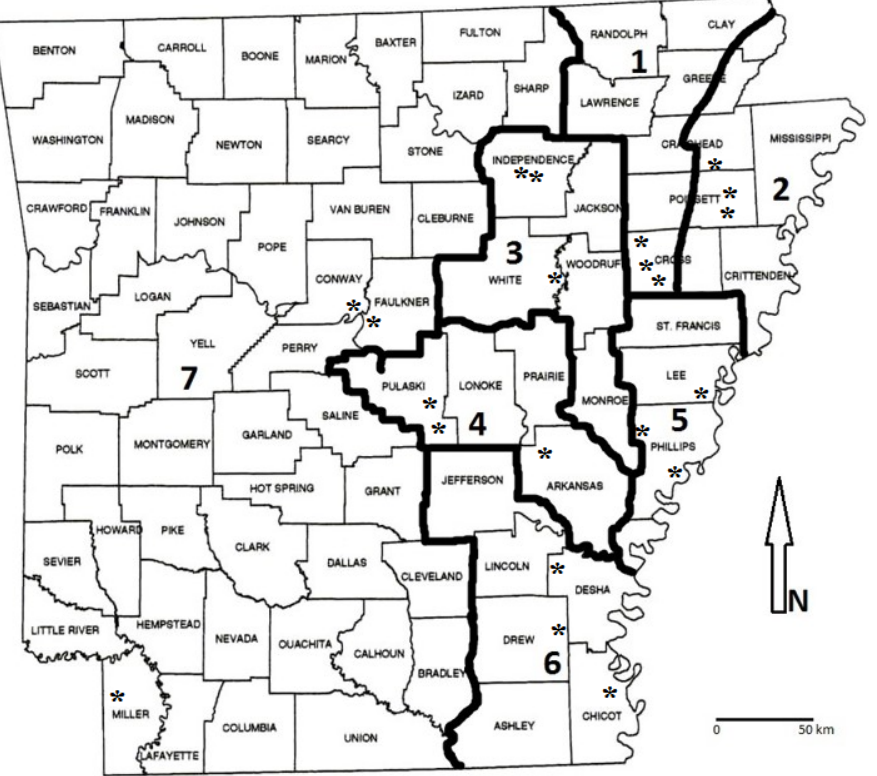
Figure 1. Seven regions for the “Grow for the Green” contest sponsored by the Arkansas Soybean Promotion Board together with the Arkansas Soybean Association. Division 1: Northeast Delta; Division 2: Northeast; Division 3: White River Basin; Division 4: Central and Grand Prairie; Division 5: East Central Delta; Division 6: Southeast Delta; Division 7: Western. Asterisks denote sampling sites in 2014 and 2015. County names are indicated within each county area.